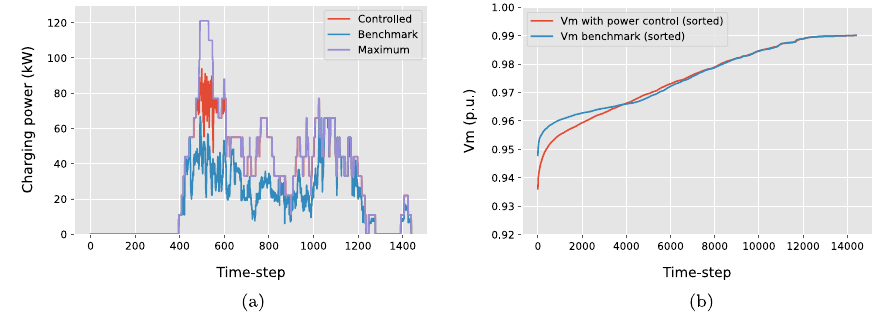
Fig. 6 a The peak shaving effect of the stochastic charging agent, b The voltage magnitudes at the charging node with and without charging control over the 10 day validation period, sorted in the ascending order